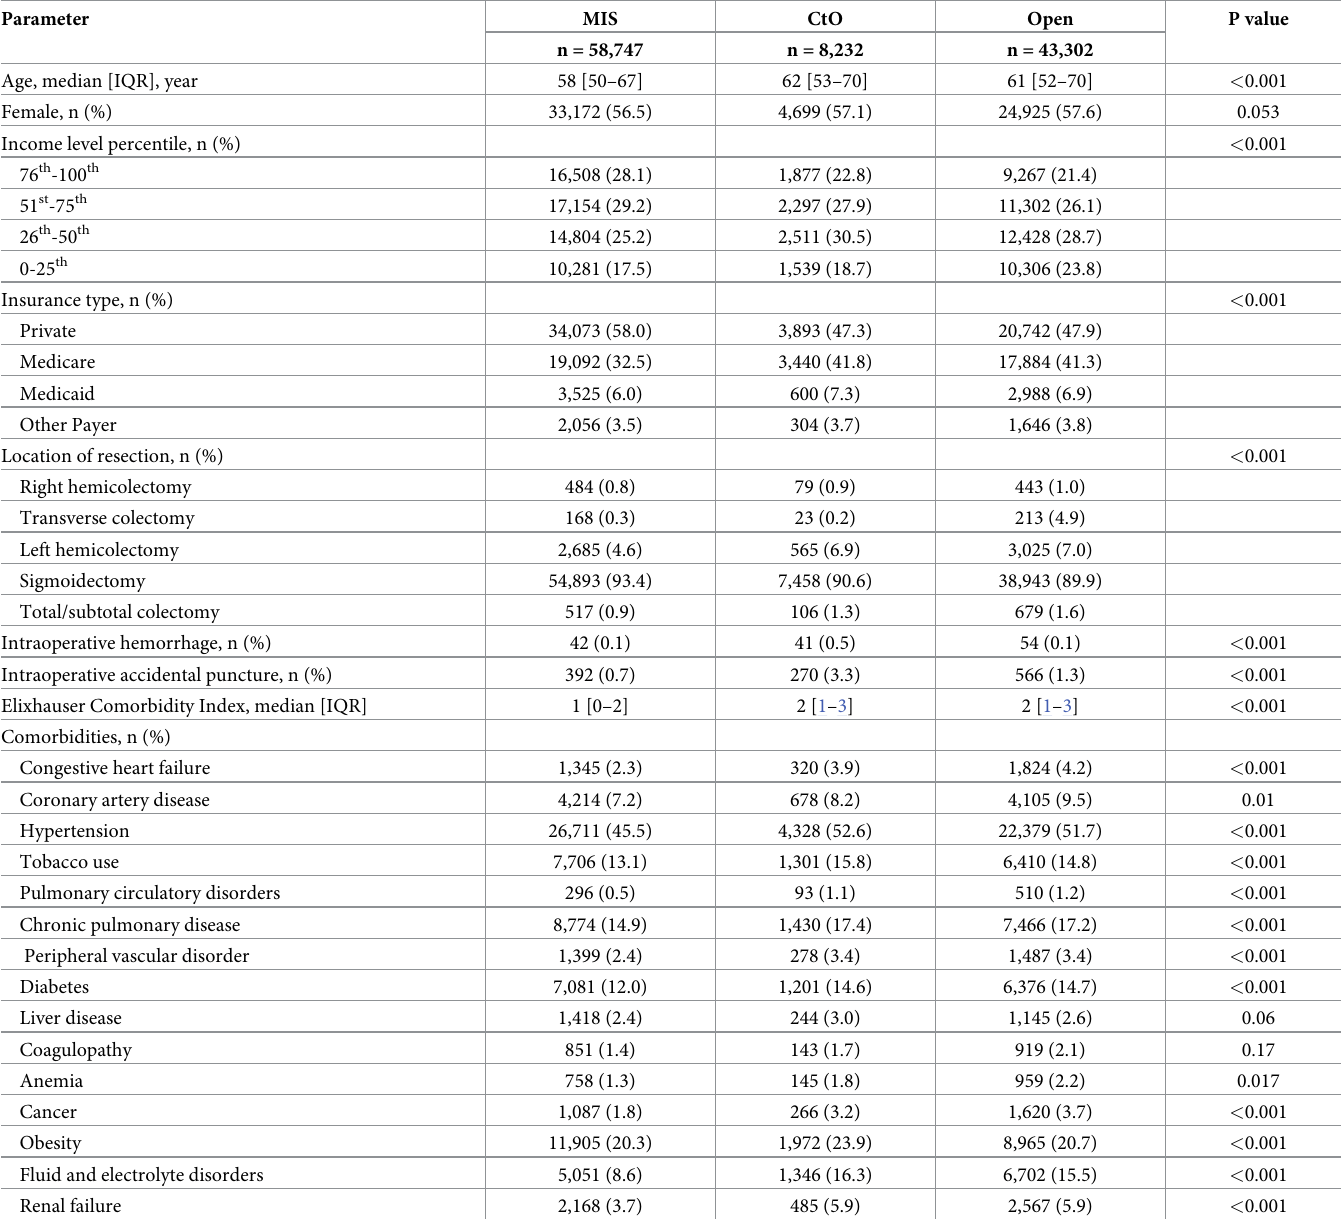
Table 1. Comparison of baseline patient characteristics of patients with diverticulitis undergoing elective colectomy, stratified by operative approach.